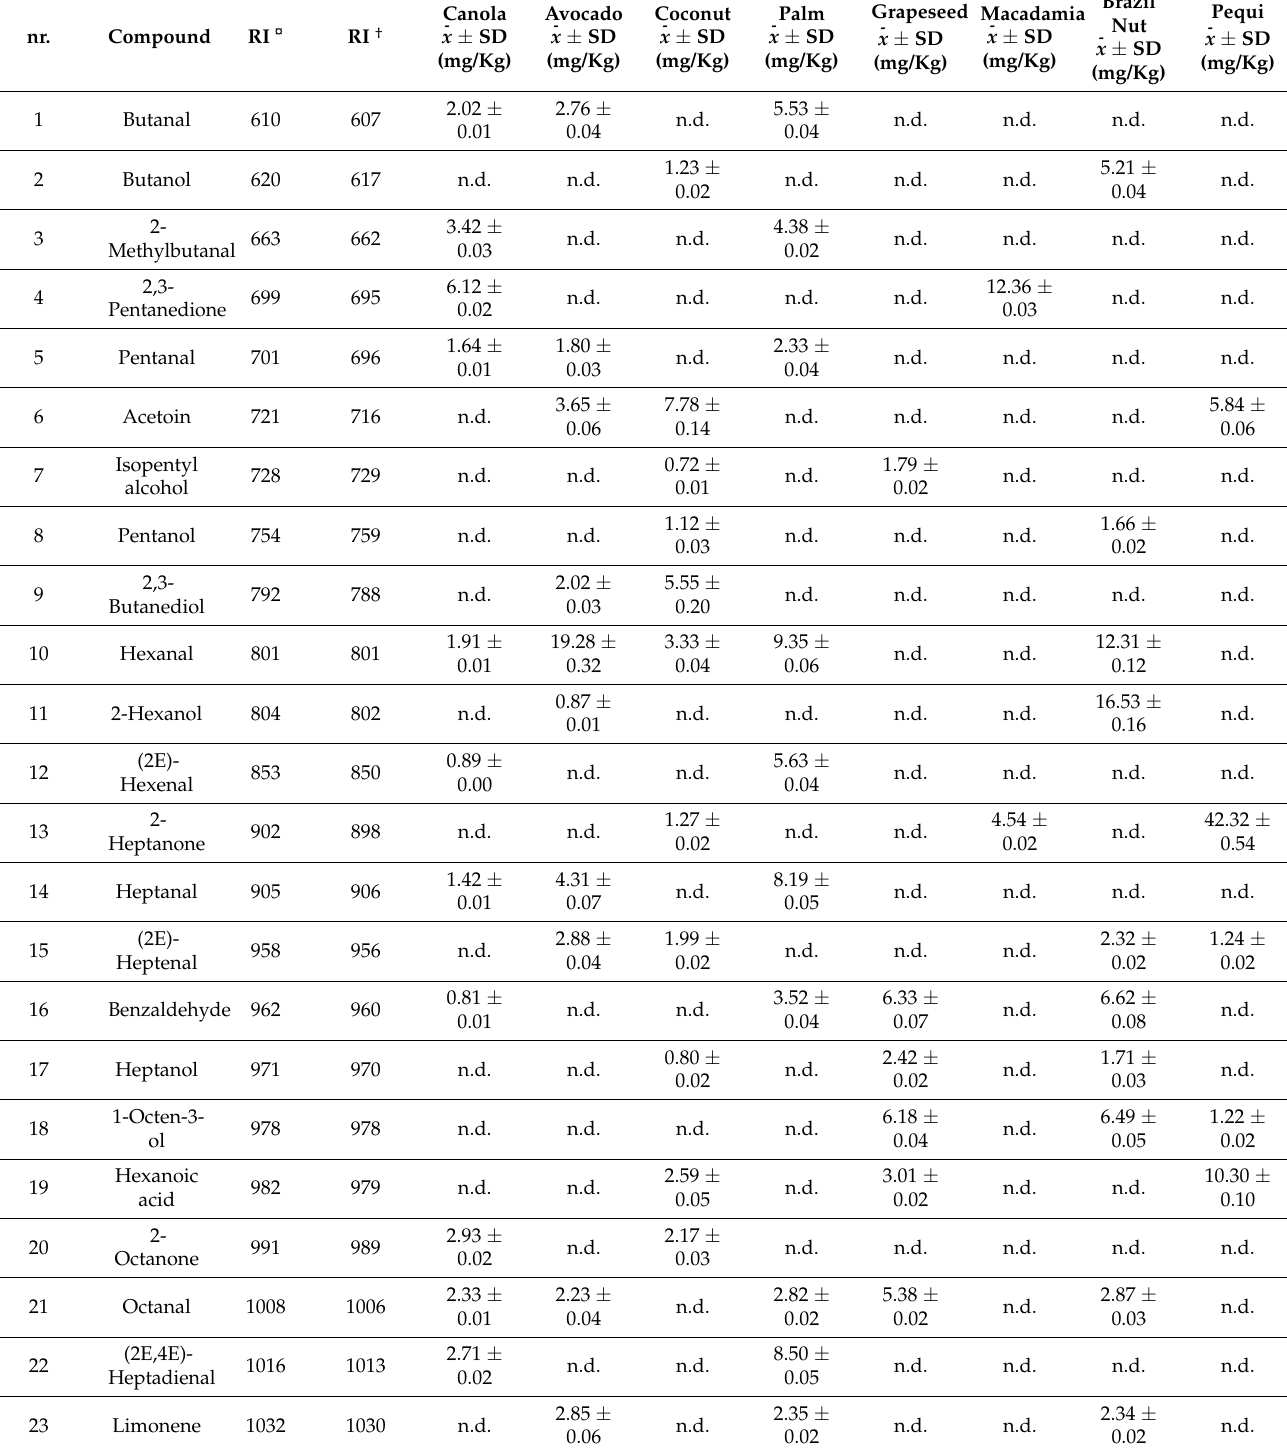
Table 4. Key volatiles sampled by HS-SPME in oil samples. Values are expressed as mg/Kg ± SD ( n =